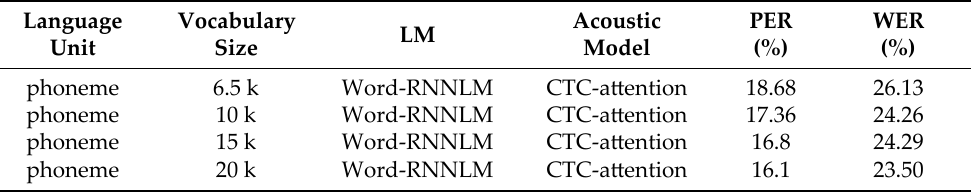
Table 3. Phoneme‑based end‑to‑end model results in different vocabulary sizes.